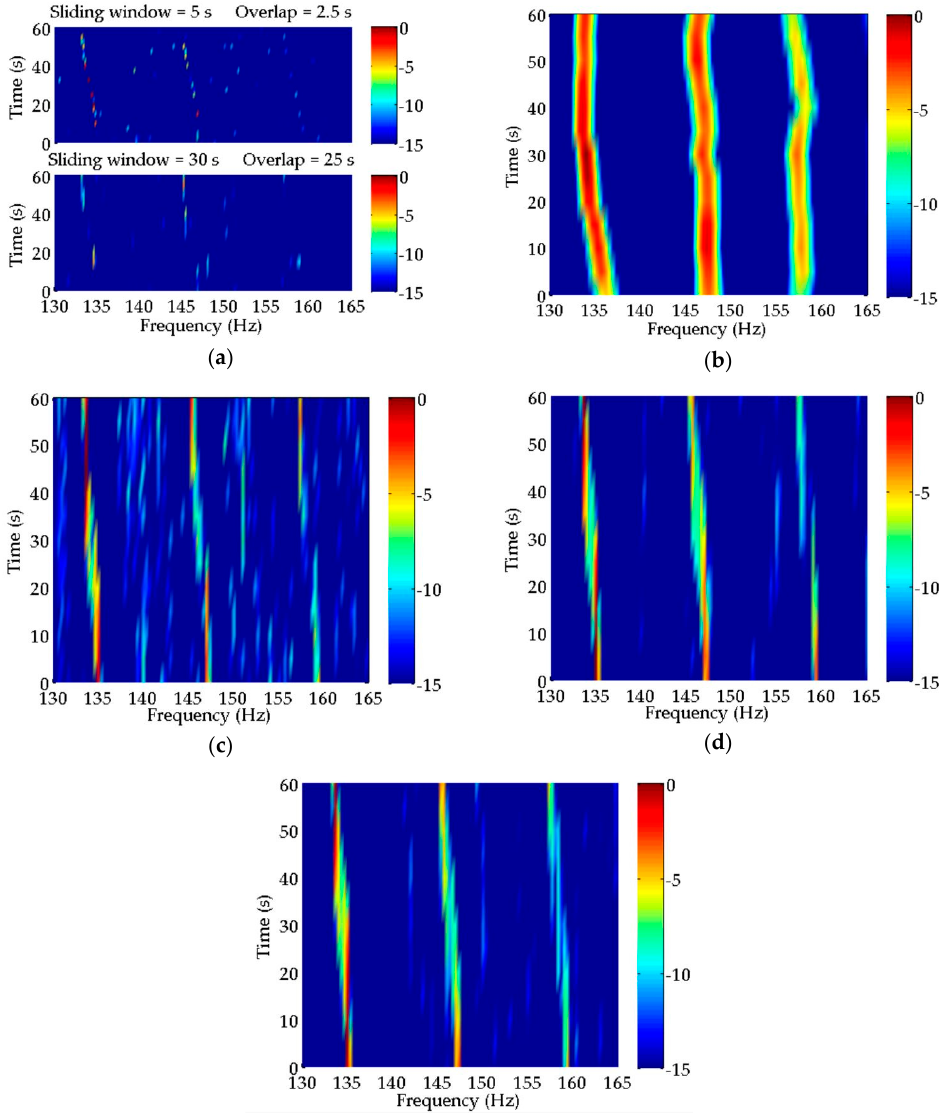
Figure 6. Estimation results of discrete spectra in simulated signals with signal-to-noise ratio (SNR) = − 10 Db obtained by ( a ) CS; ( b ) MUSIC; ( c ) CPSCI; ( d ) CPSII and ( e ) CCPSCI. ( a ) In the estimation results of CS, the number of breaking points increases in both subfigures. The weakest discrete spectrum is hard to detect. ( b ) The decrease in SNR leads to the further increase in the frequency errors of discrete spectra estimated by MUSIC. In ( c , d ), the discontinuity of discrete spectra estimated by CPSCI and CPSII is obvious, which brings di ffi culties to target identification and classification. ( e ) CCPSCI can still provide the spectral estimation result with a relatively high degree of continuity and stability.